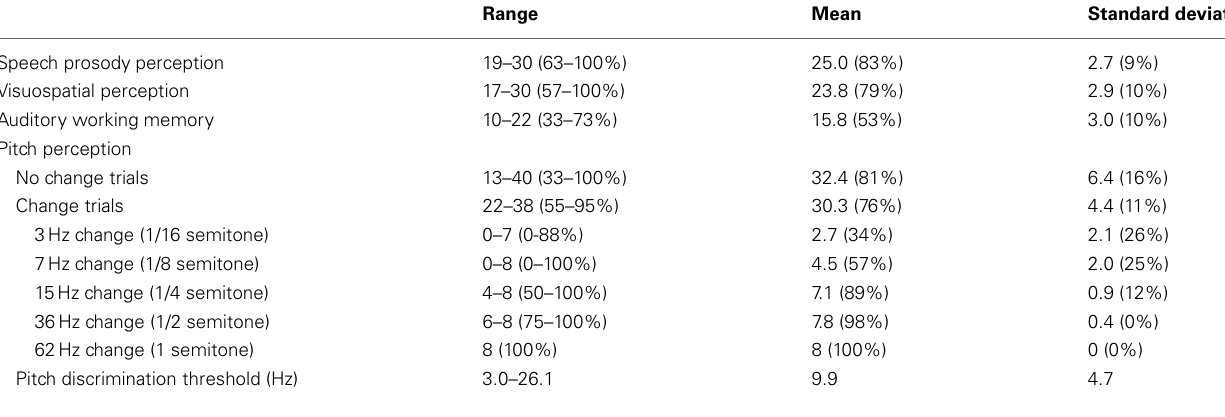
Table 4 | Other tests of perception and memory: basic descriptive statistics.